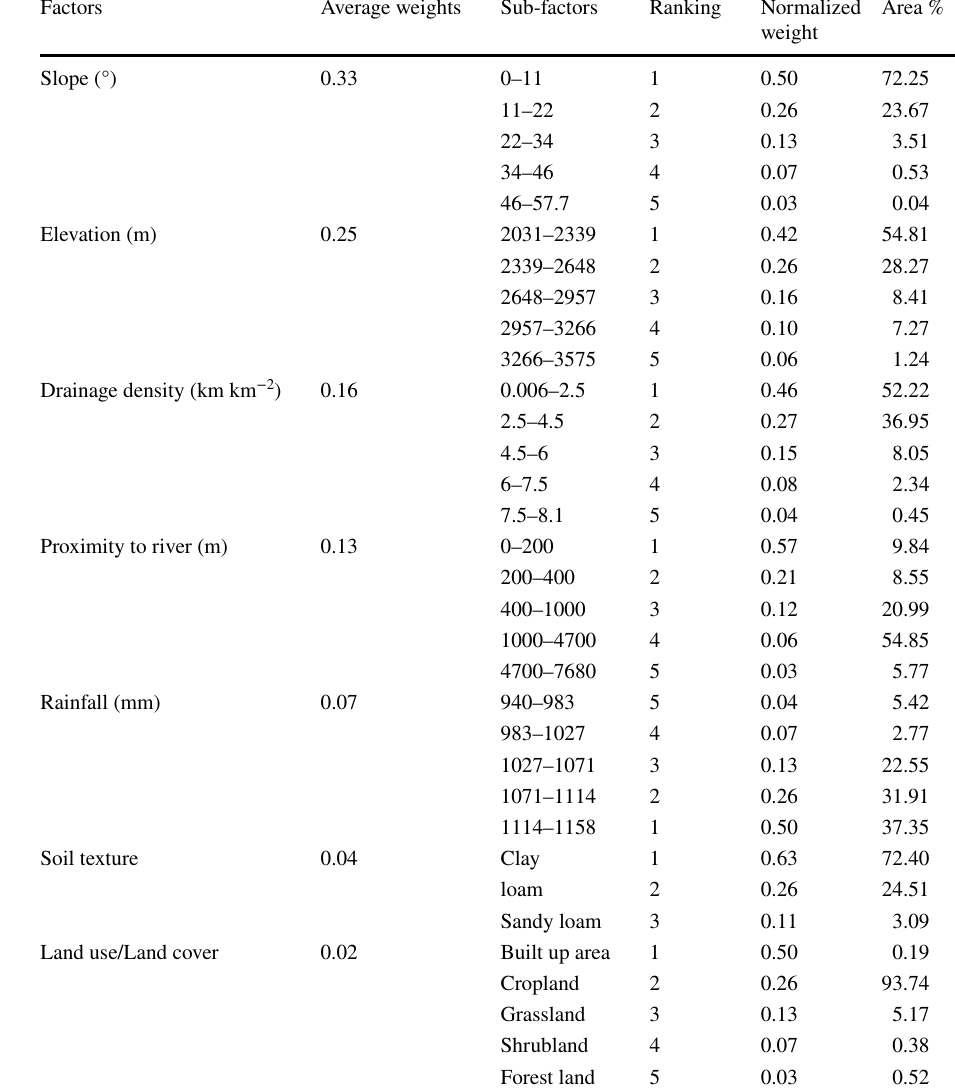
Table 9 AHP rank and weights for the parameters of flood hazard for Teji